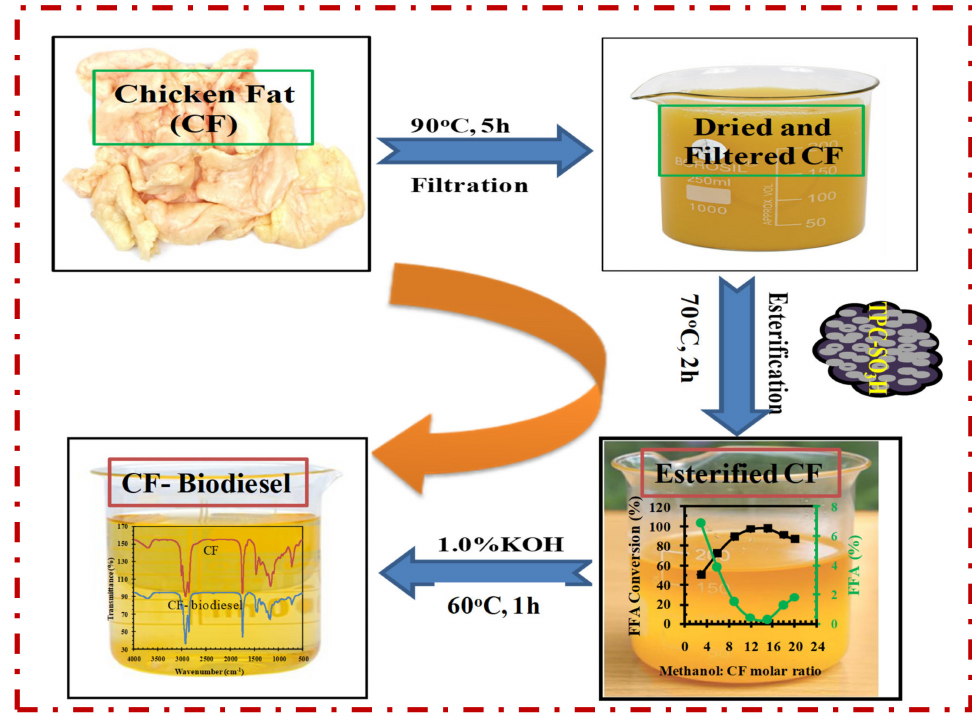
Figure 2. Biodiesel synthesis via two-step conversion